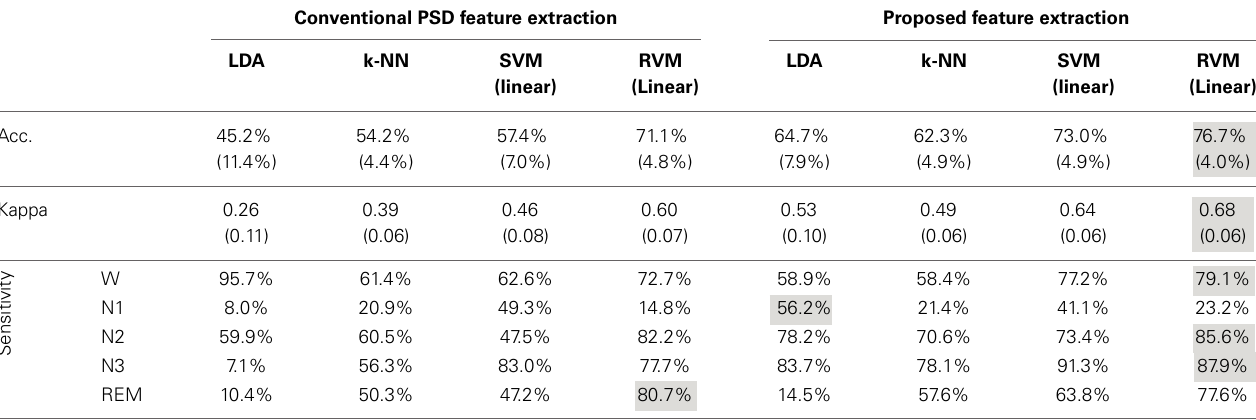
Each lattice represents the mean value of the validation index from ten subjects, and the corresponding bracket is the standard deviation. Acc. and kappa represents overall accuracy and Cohen’s kappa coefficient, respectively. Highlighted parts display the optimum performance of all comparison